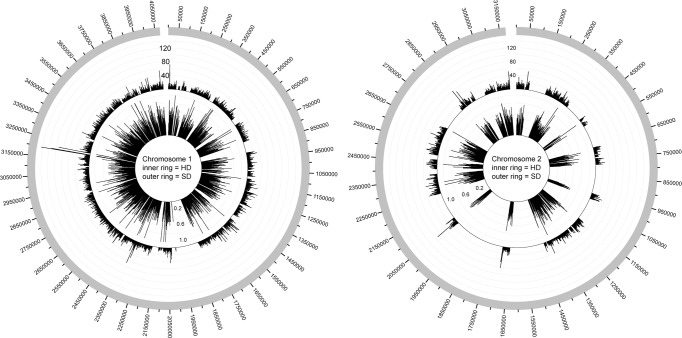
Plots of single nucleotide polymorphism (SNP) density and homoplasy density (HD), across the two chromosomes of the reference isolate, K96243 [30].The outer ring represents the number of informative SNPs across 1-kb genomic intervals. The inner ring indicates the number of homoplasious SNPs, as determined by a retention index (RI) value <0.5 calculated by Paup [35], divided by the total number of informative SNPs over the same 1-kb genomic interval. HD and SD values were visualized with Circos [36].